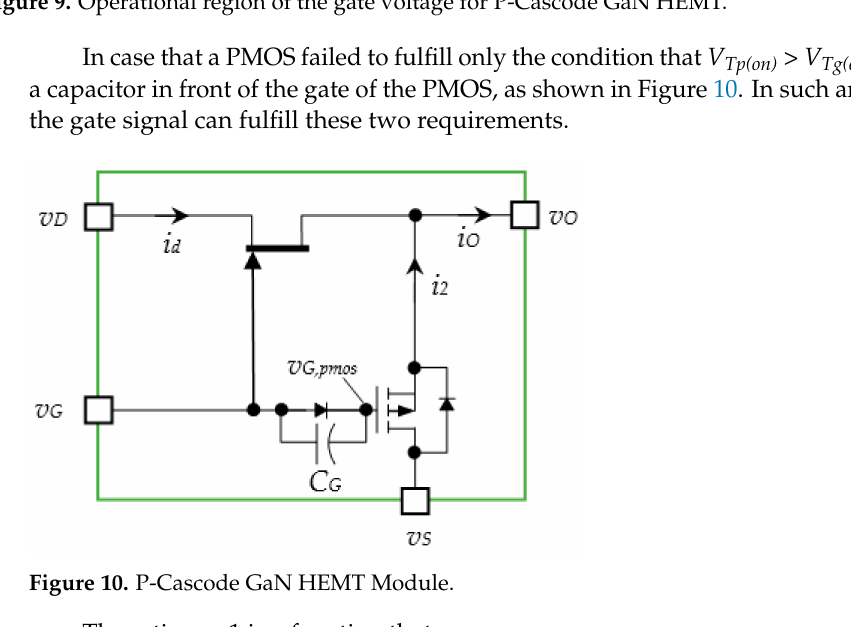
Figure 9. Operational region of the gate voltage for P-Cascode GaN HEMT.